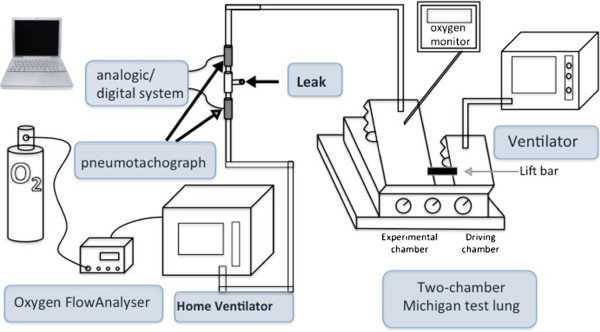
Show the bench test.